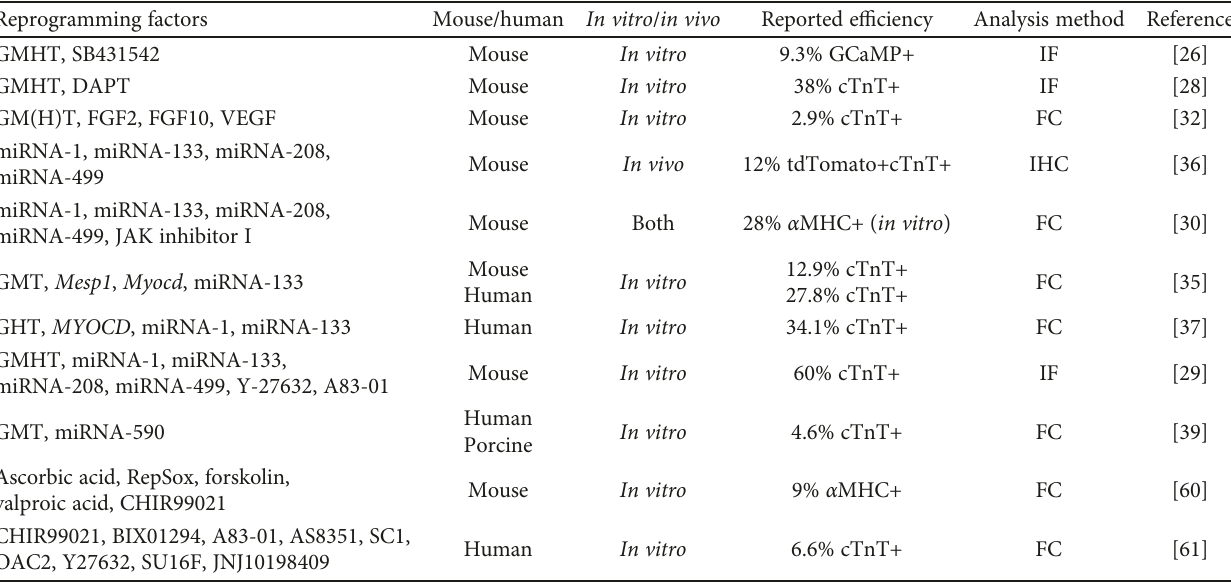
Table 2: Summary of direct cardiac reprogramming